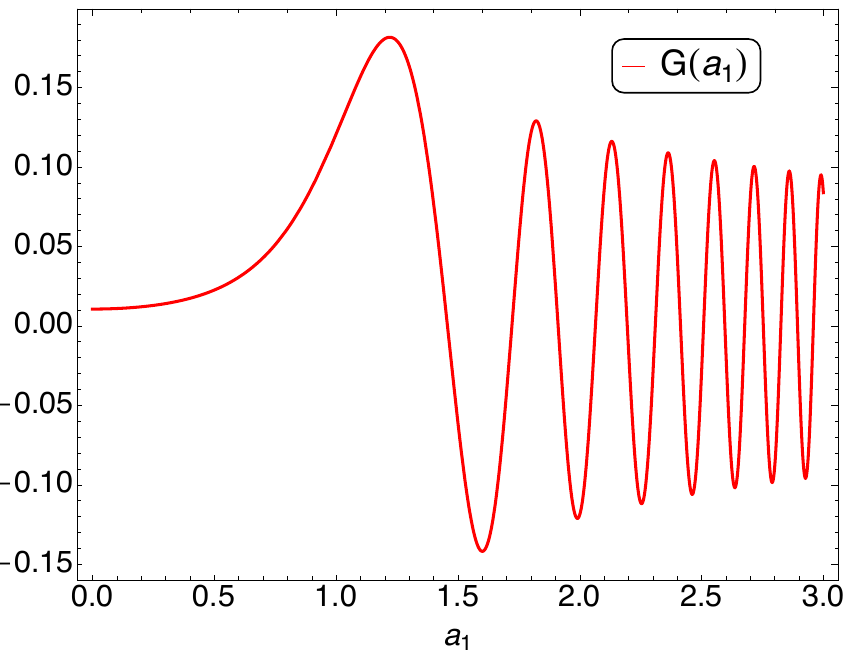
. Here we plot the exact 4Λ √ q 1 is varied from 0 to larger